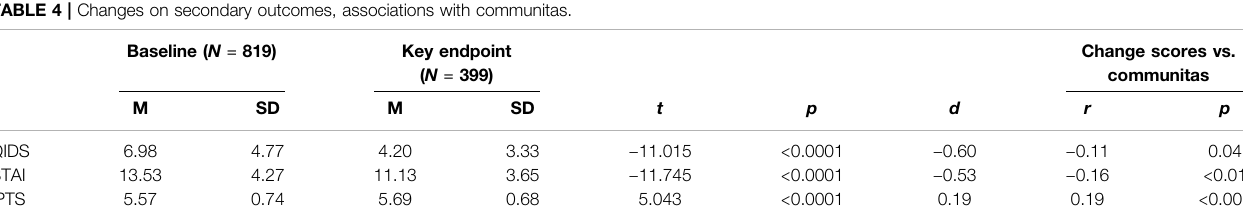
TABLE 4 | Changes on secondary outcomes, associations with